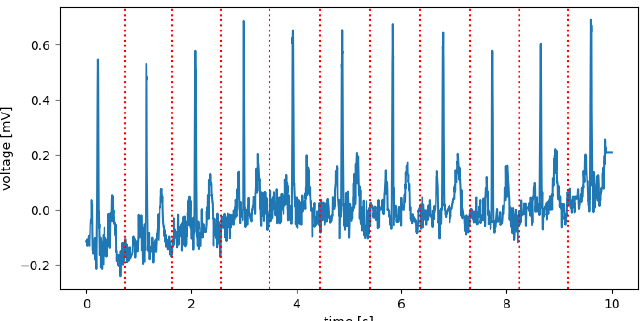
Figure 4. Sample record of NORM class for I lead, with places for section cuts (Red).